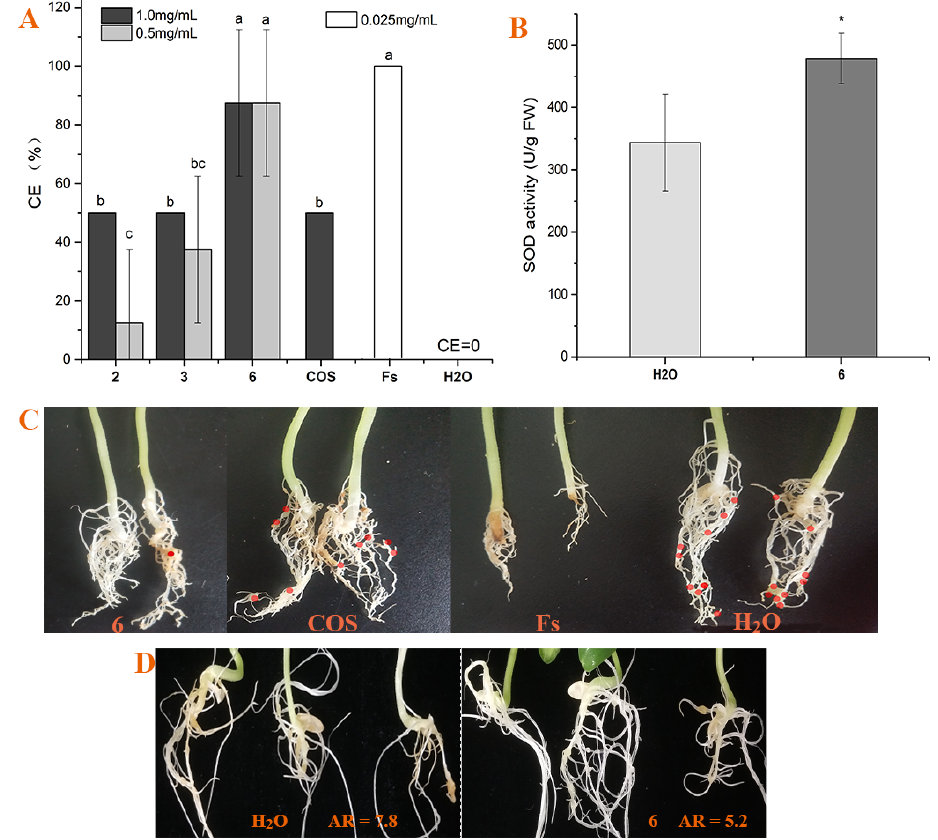
Figure 6. Control effect of COS derivatives on Meloidogyne incognita : ( A ) was the control effect of COS derivatives; ( B , C ) were the effect of derivative 6 on root SOD, where the red point represents the root-knot; ( D ) induced resistance activity of the derivative, among which AR was the average number of root-knot. Different letters (a, b, and c, etc.) and * above histogram means different at p ≤ 0.05 according to t -test.